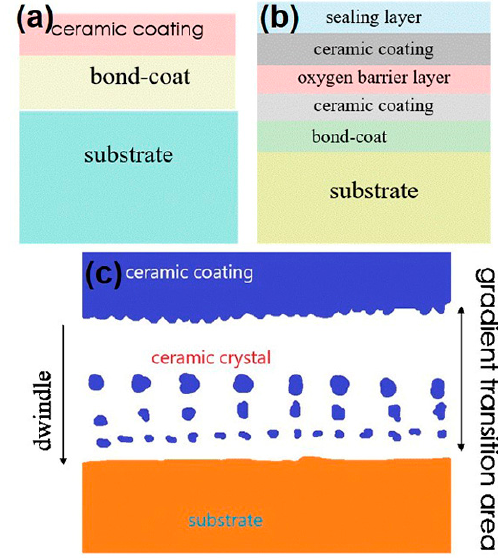
Figure 3. Main structural systems of thermal barrier coatings. ( a ) Typical double-layer thermal barrier coating; ( b ) multi-layer thermal barrier coating; ( c ) Electron beam-physical vapor deposition (EB-PVD) gradient thermal barrier coating.